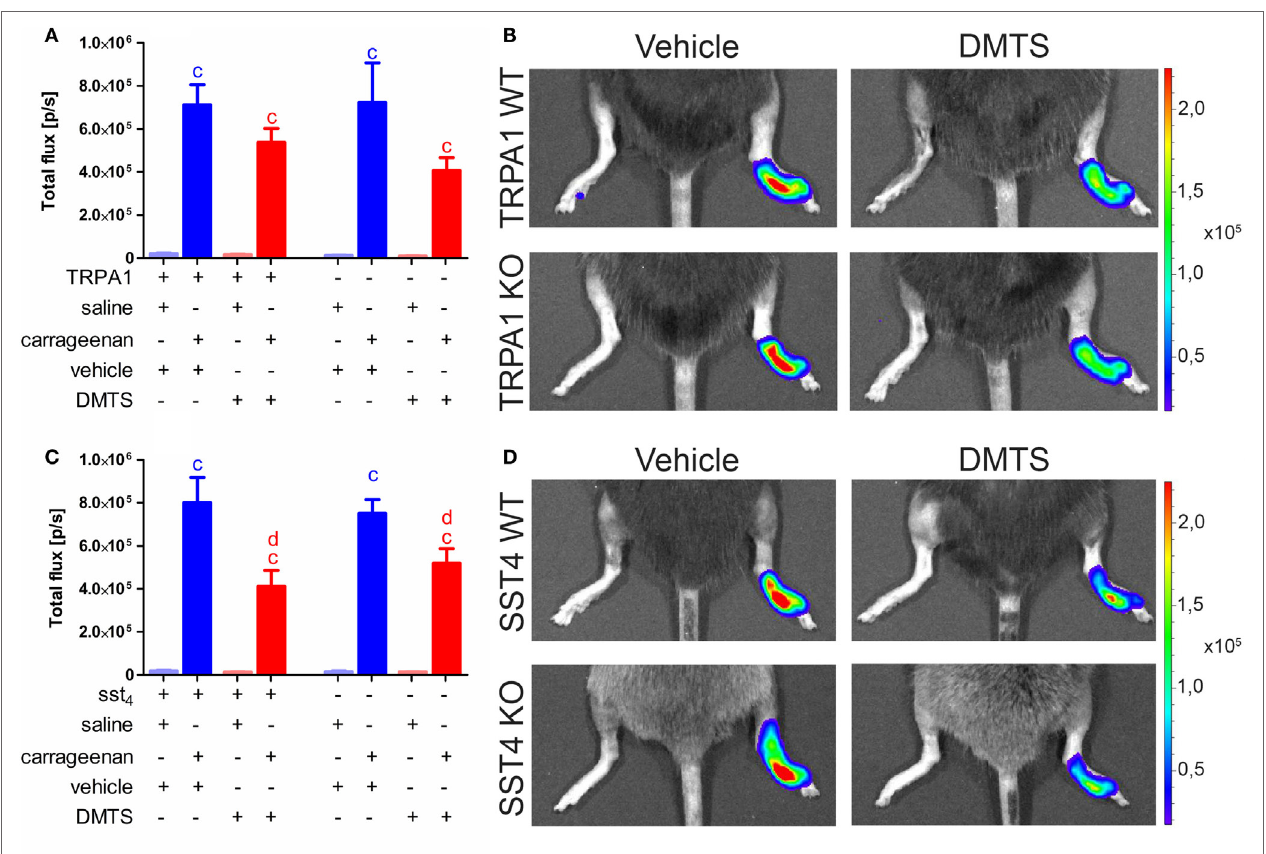
FigUre 6 | Dimethyl trisulfide (DMTS) administration (250 µmol/kg, i.p.) decreases myeloperoxidase (MPO) activity indicated by luminol bioluminescence in sst4 receptor WT and KO mice undergoing carrageenan-induced inflammation of the hind foot. (a) Bioluminescence in saline and carrageenan-treated (3% in 20 µL saline) hind paws of transient receptor potential ankyrin 1 (TRPA1) WT and KO animals. (B) Representative bioluminescent images of saline and carrageenan-treated (3% in 20 µL saline) hind paws of TRPA1 WT and KO mice depicting MPO activity. (c) Luminol bioluminescence in saline and carrageenan-treated (3% in 20 µL saline) hind paws of sst4 receptor WT and KO mice. (D) Representative bioluminescent images of saline and carrageenan-injected (3% in 20 µL saline) hind paws of sst4 WT and KO animals. Data are shown as mean ± SEM. n = 6–9. c p < 0.05 vs. saline-injected paws. d p < 0.05 vs. carrageenan-injected paws of